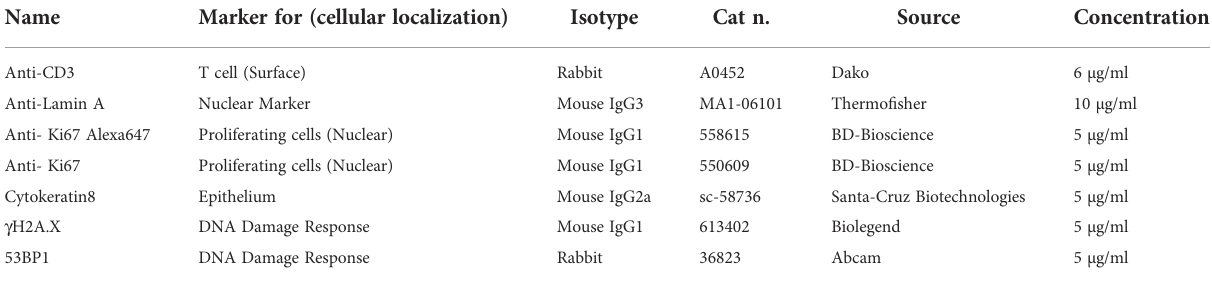
TABLE 1 List of the employed primary